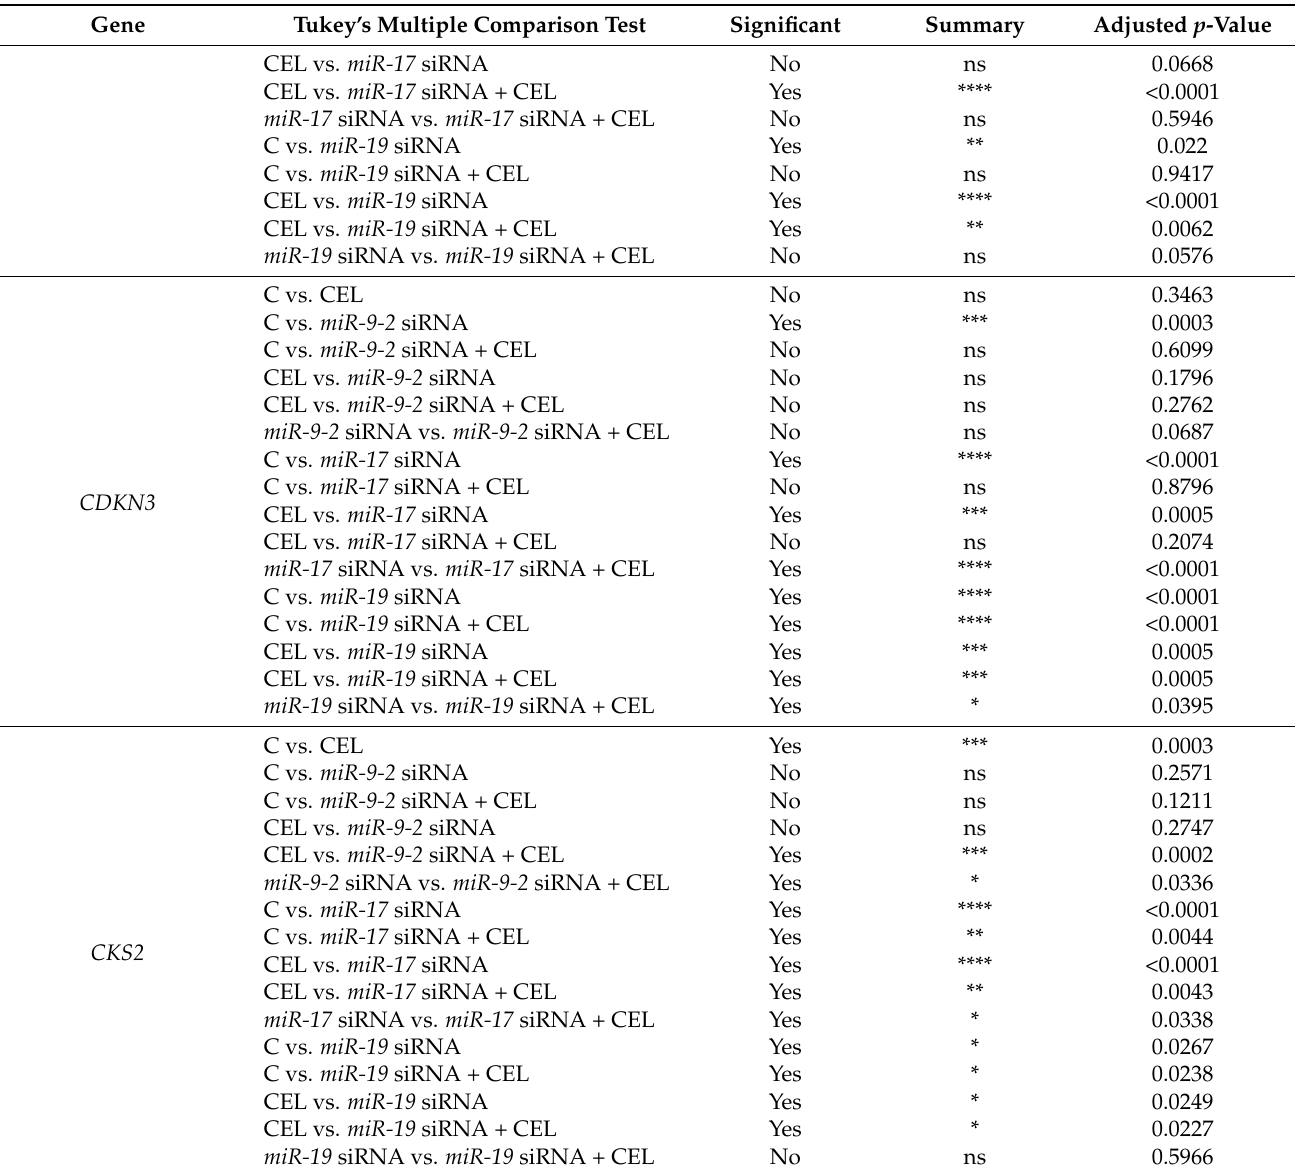
Gene Tukey’s Multiple Comparison Test Significant